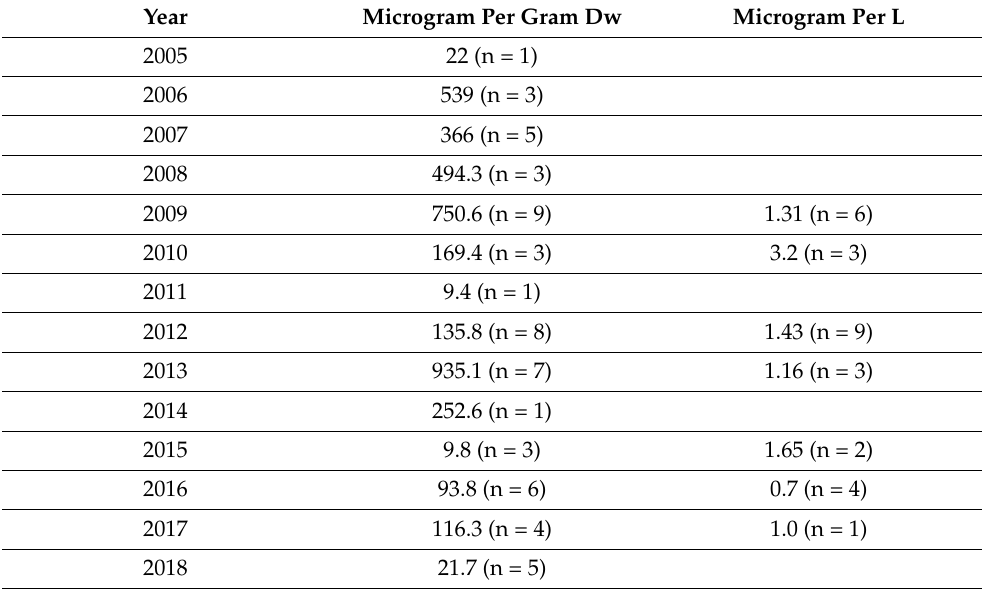
Table 1. Maximal Concentrations of Microcystins in Lake Kinneret from 2005 to 2018 [5], given in microgram Microcystins per gram biomass (dry weight) of Microcystis sp. biomass (dry weight) and microgram per liter of sampled waters (n = number of samples)